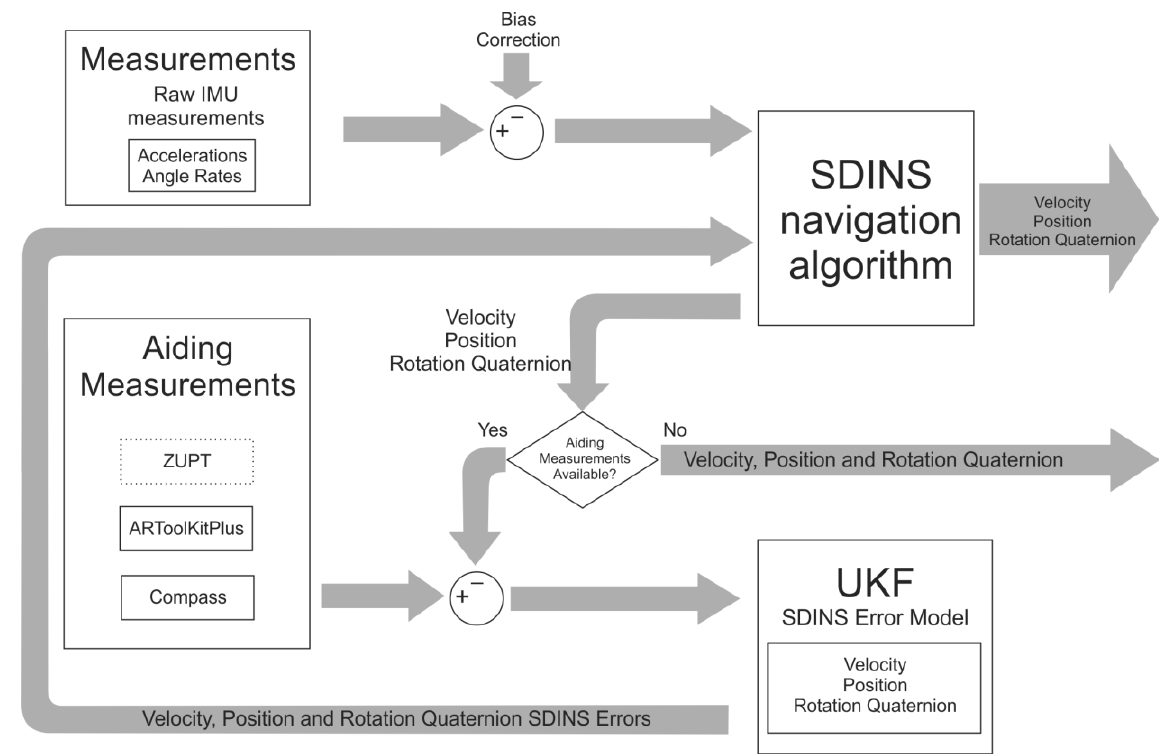
Figure 2. Flowchart of the proposed